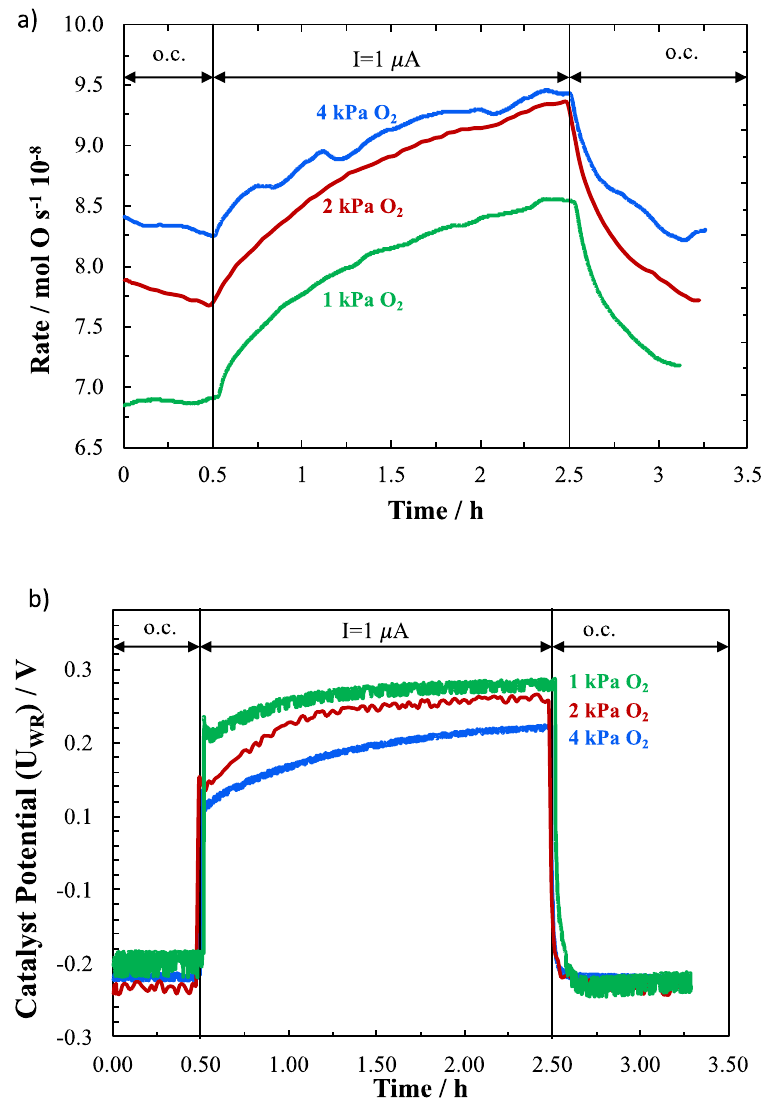
Figure 8. ( a )Transient rate response of Pd catalyst at different O 2 partial pressure under 1 μA galvanostatic application and ( b ) the corresponding catalyst potential response. Conditions: T = 450 °C, 2 kPa of CH 4 . Flow rate: 100 ccm.